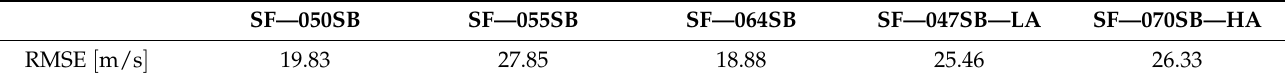
Table 5. RMSE of the modeled curves of UPV evolution (P-wave) for all mix